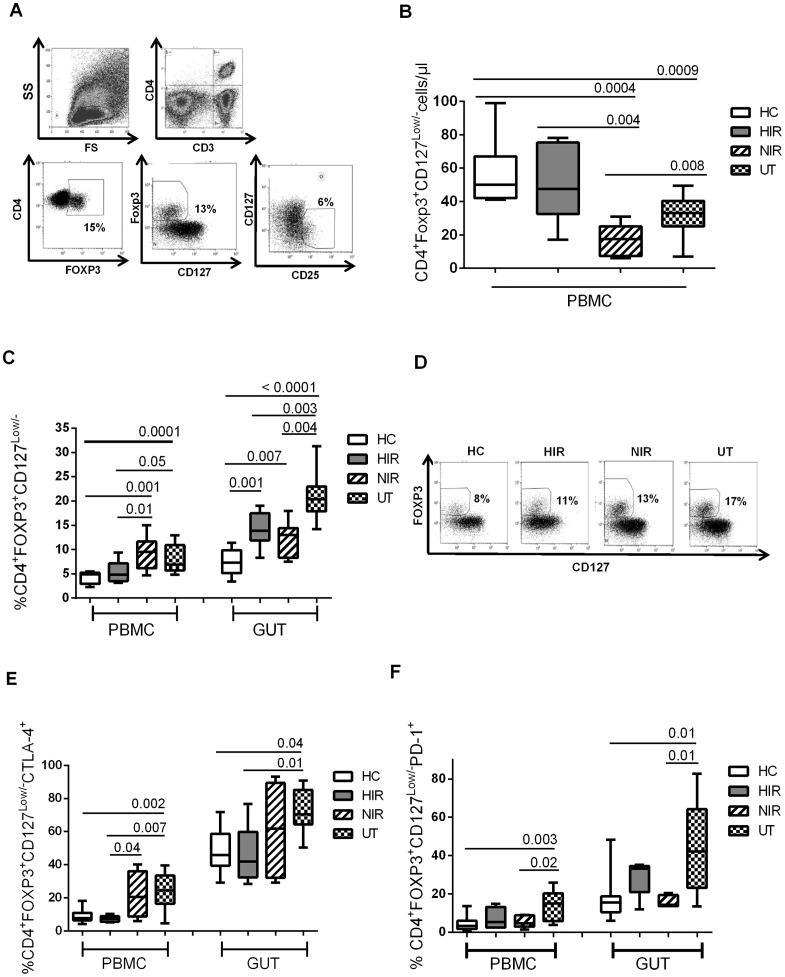
Effect of HAART IN Treg frequency and phenotype in gut and blood tissues.A) Representative figure showing the frequency of Treg in gut in an HIV-infected subject. Three different strategies were used to define Treg in the gated of CD3+CD4+ T-cells: CD4+Foxp3+, CD4+Foxp3+CD127Low/− or CD4+CD25+CD127Low/−. B) Absolute counts of circulating Treg (CD4+FOXP3+CD127Low/−). C) Treg frequency in PBMC and gut. D) Representative examples of Treg (CD4+Foxp3+CD127Low/−) in the different groups of individuals. E) Frequency of Treg expressing CTLA-4+. F) Frequency of Treg expressing PD-1+ in samples from healthy controls, HIR, NIR and untreated patients.